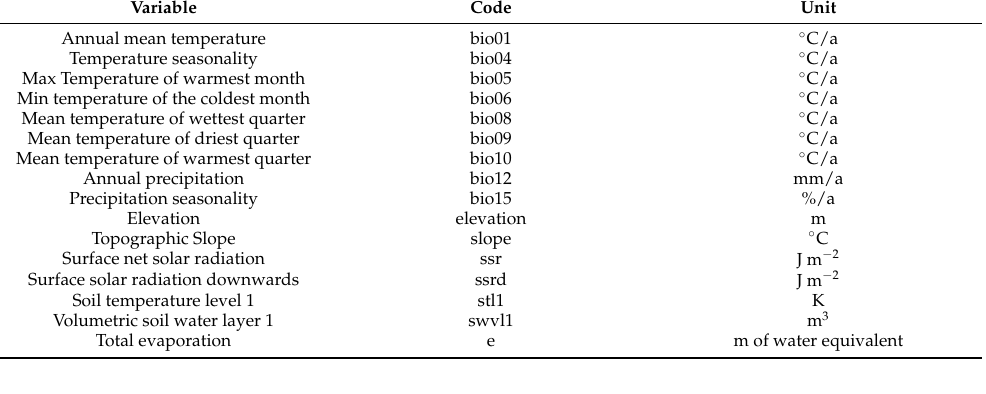
Table A2. Biometeorological and topographic factors.